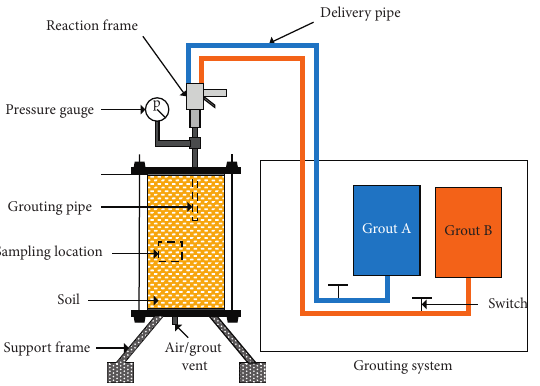
Figure 1: Schematic diagram of grouting device.